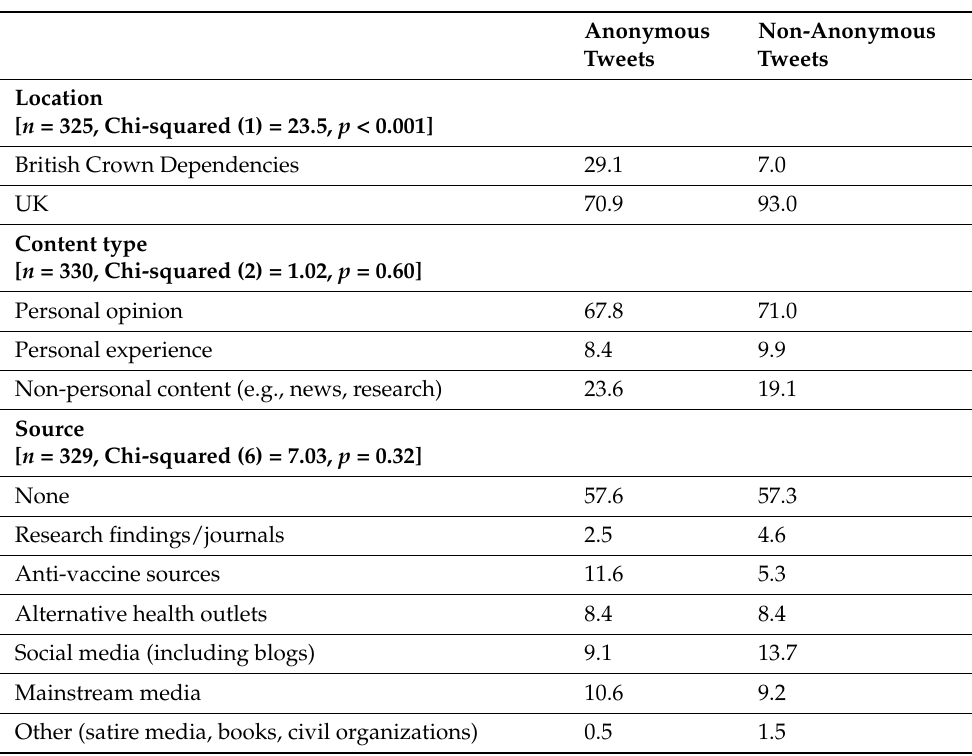
Table 3. Differences in content characteristics of anonymous and non-anonymous anti-vaccine tweeters (cross-tabulation with chi-squared